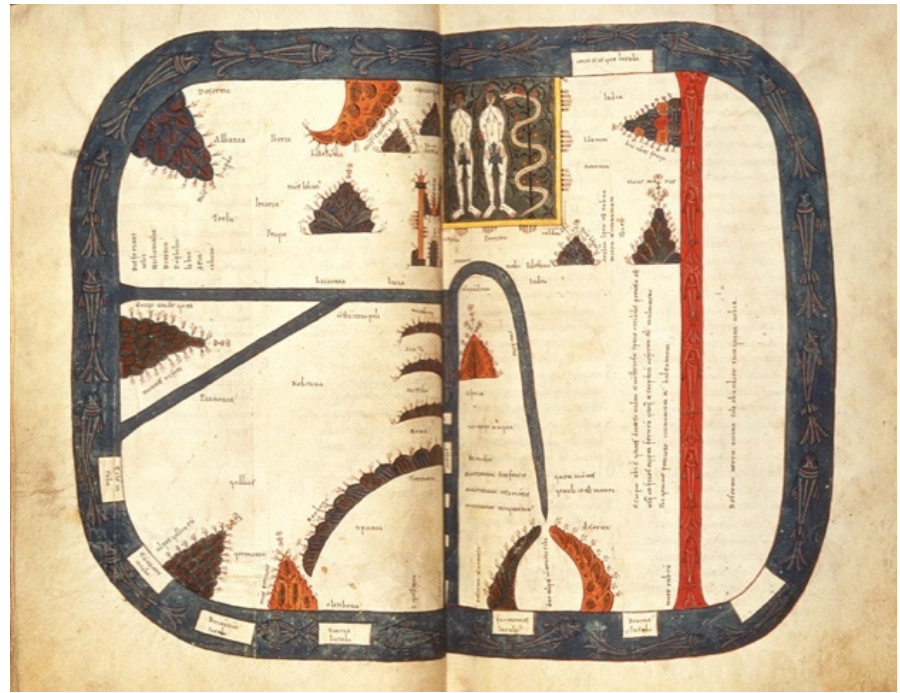
Figure 3. The Map of the Garden of Eden. c.a. 1009. https://www.gutenberg.org/files/18757/18757-h/images/map06.jpg (accessed on 18 July 2022).